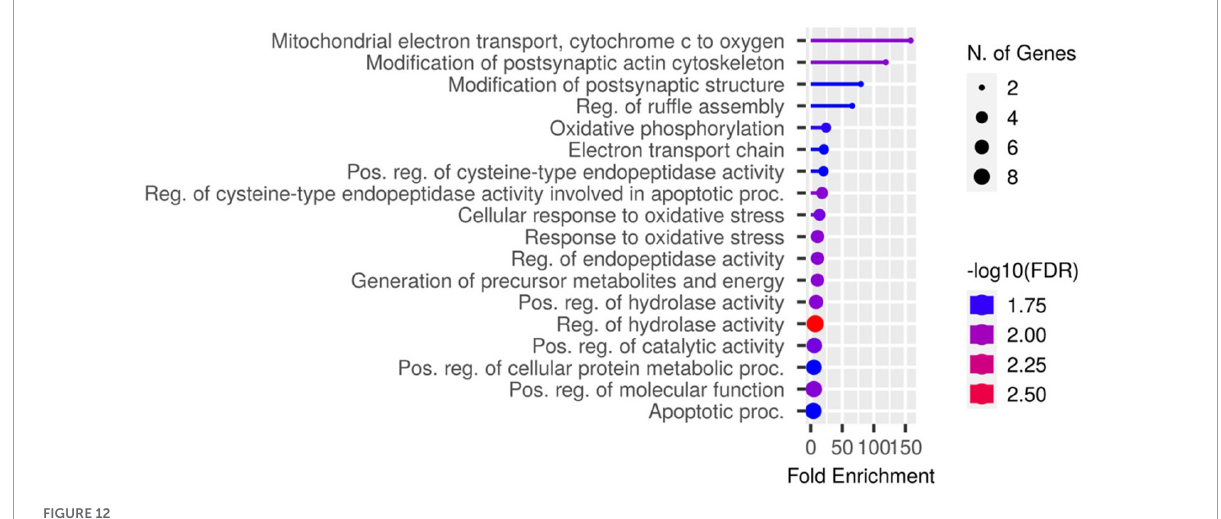
FIGURE12 A chart identifying the GO biological processes for the genes identified in network 1.